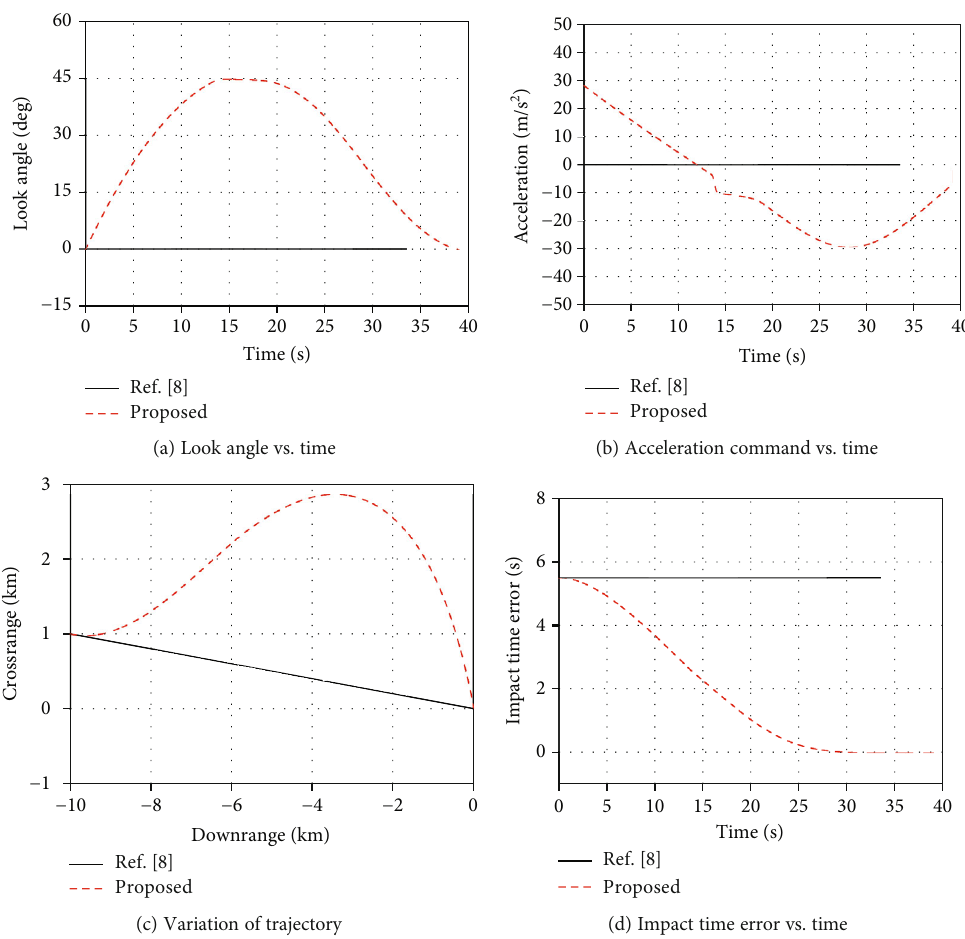
Figure 7: Simulation of ITCG laws with fi eld-of-view constraint ( ϕ